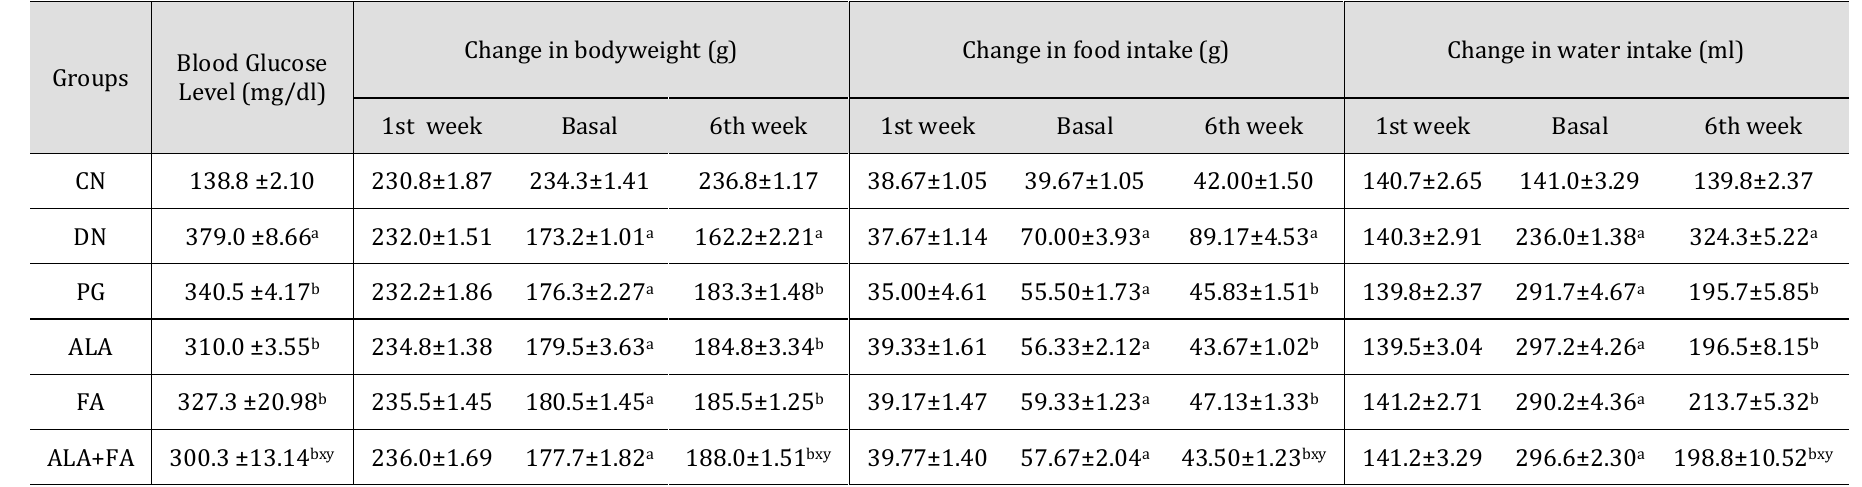
Table 1. Effect of ALA, FA and their combination on blood glucose level, body weight, food, and water intake in diabetic neuropathy induced rats